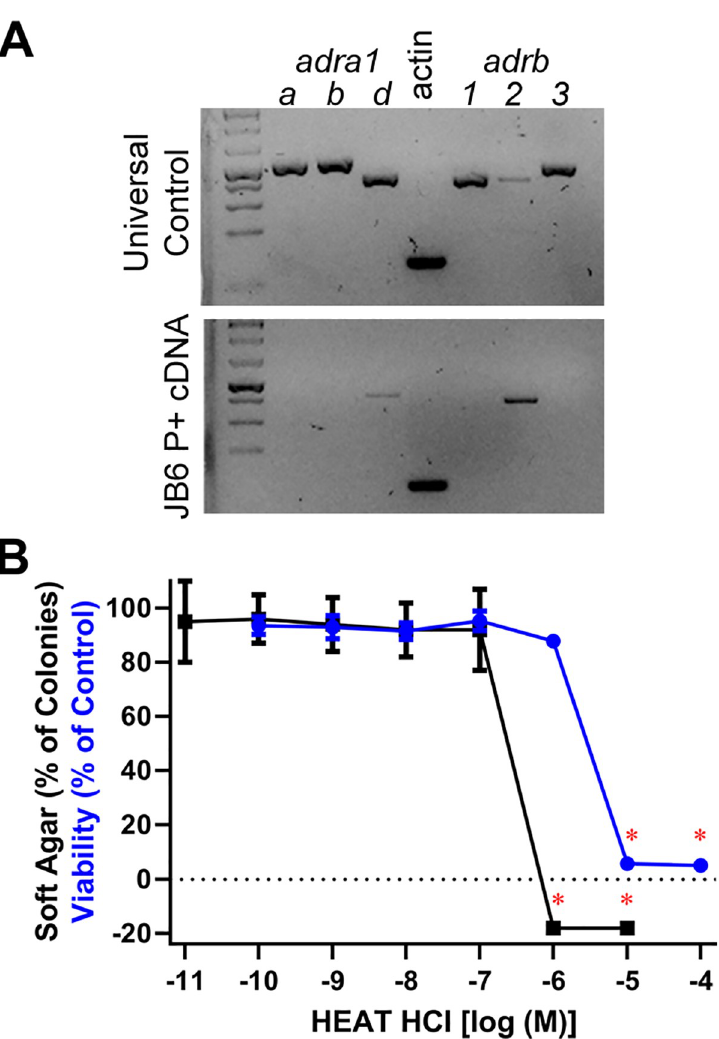
Fig 4. Expression of α 1-ARs and role of α 1-ARs in EGF-induced neoplastic transformation of JB6 P+ cells. (A) Universal mouse (positive control) and JB6 P+ cDNA was amplified with primers specific for each α 1- and β -AR. Only α 1D-AR and β 2-AR are expressed in JB6 P+ cells. (B) 10 ng/mL EGF-mediated JB6 P+ cell colony formation in soft agar (black) n = 8 and 72-hour SRB cell viability assay (blue) n = 6. Data represented as mean ± SD after normalization to control (EGF minus DMSO control for soft agar, and DMSO for SRB and MTS). A red asterisk ( � ) indicate that the HEAT HCl data are statistically lower than control (p < 0.05 as per an ANOVA with Tukey-Kramer post hoc test), which is not shown for the colony formation assay, indicating